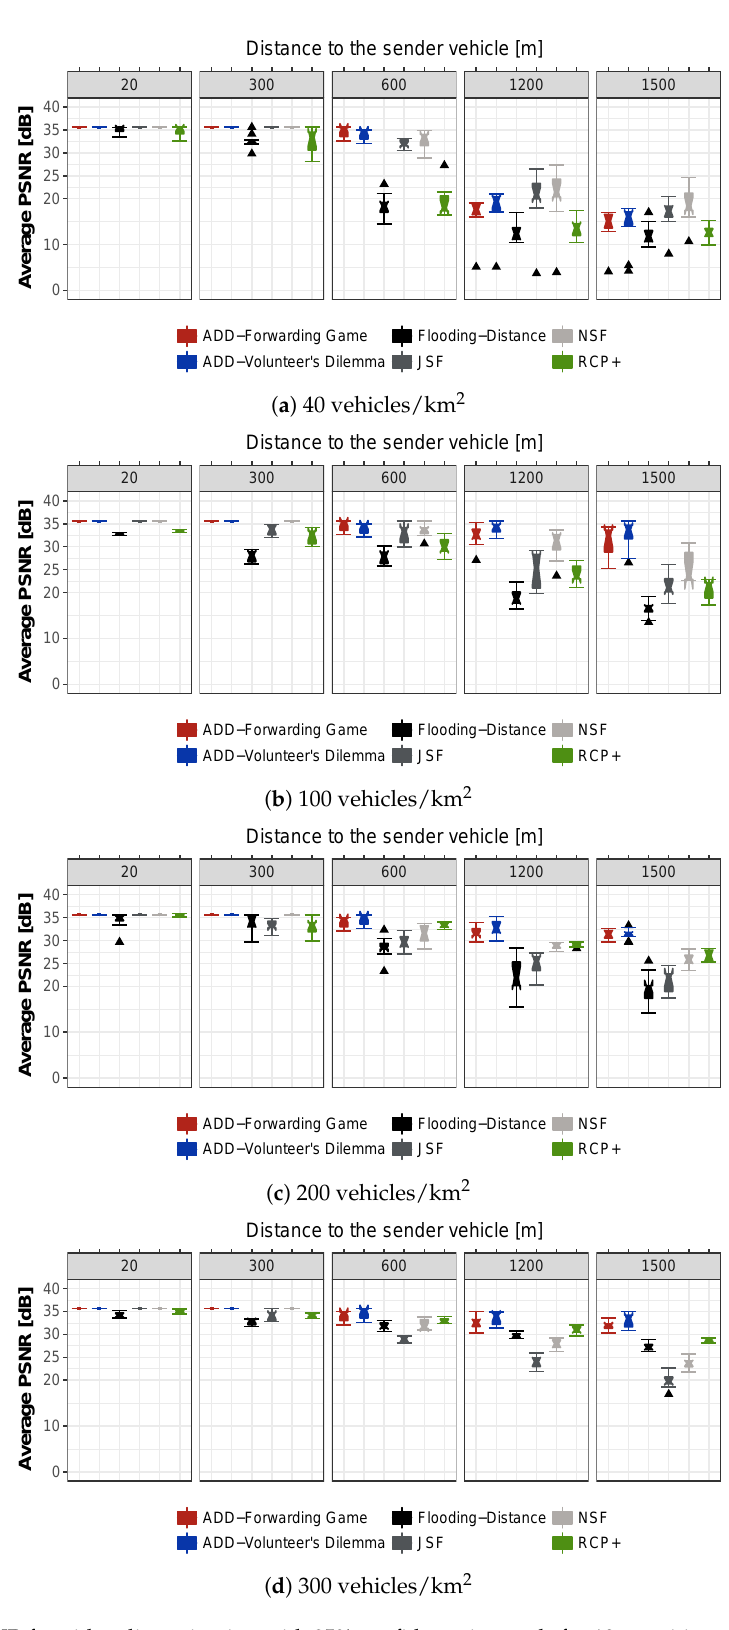
Figure 7. PSNR for video dissemination with 95% confidence intervals for 10 repetitions per point with independent seeds. Different network densities in a 2.5 km × 2.5 km urban region in Berlin,